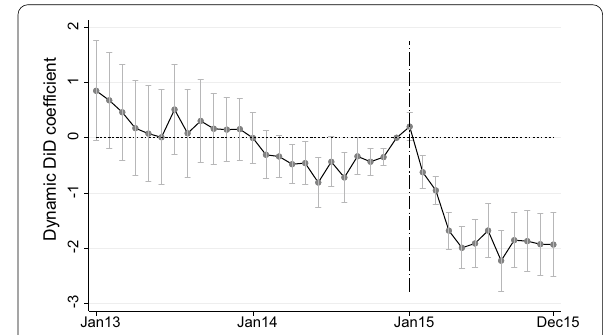
Fig. 3 All-items dynamic DID coefficients. Notes DID regression of the HICP all-items index with dynamic lags/leads, as well as country and time fixed effects, following regression 2. Standard errors are clustered at the country level. Coefficients are computed from the HICP monthly all-items consumer price index from January 2013 to December 2015, using post-January 2015 Switzerland as a treatment and 33 European countries as a GDP-weighted control group. Bands show the 95% confidence interval for each coefficient. Data source: Eurostat